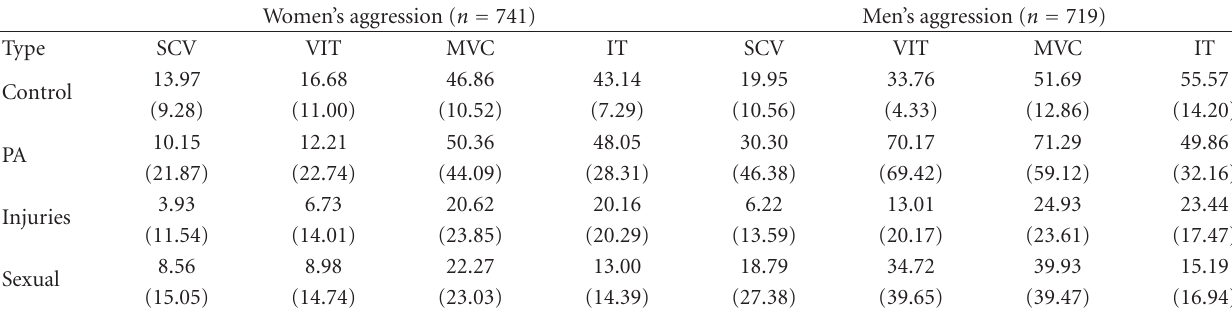
Table 4: Women’s and men’s mean (and standard deviations) aggression by relationship type.